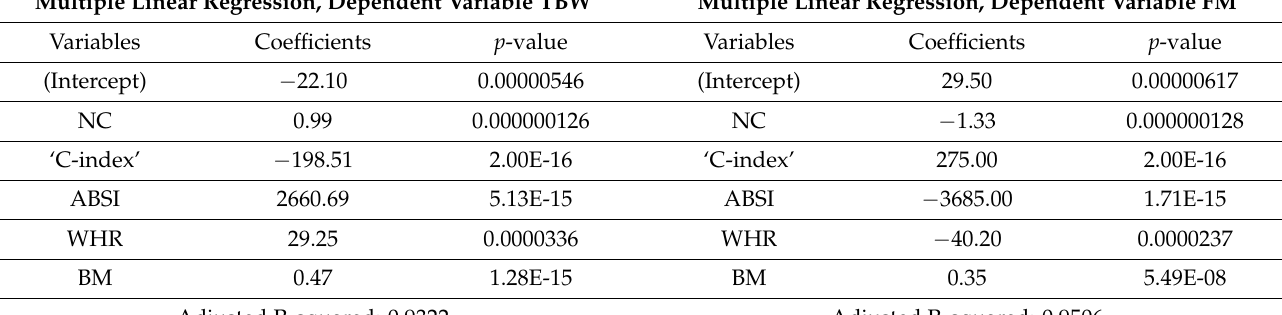
Table 3. Multiple Linear regression